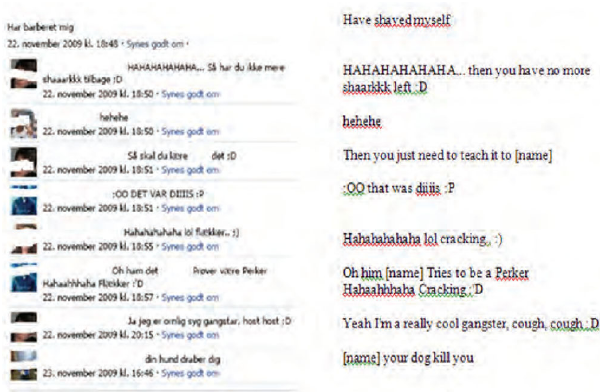
Fig. 2 Selected example of polylanguaging from Jørgensen et al. (2011, p. 26). The “ majority boy ” makes use of resources from the minority ’ s language (the word “ shark